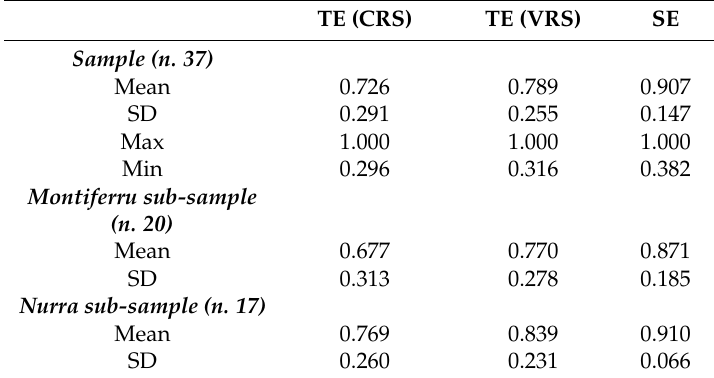
Table 2. Estimation of technical and scale efficiency by Data Envelopment Analysis (DEA). TE (CRS) TE